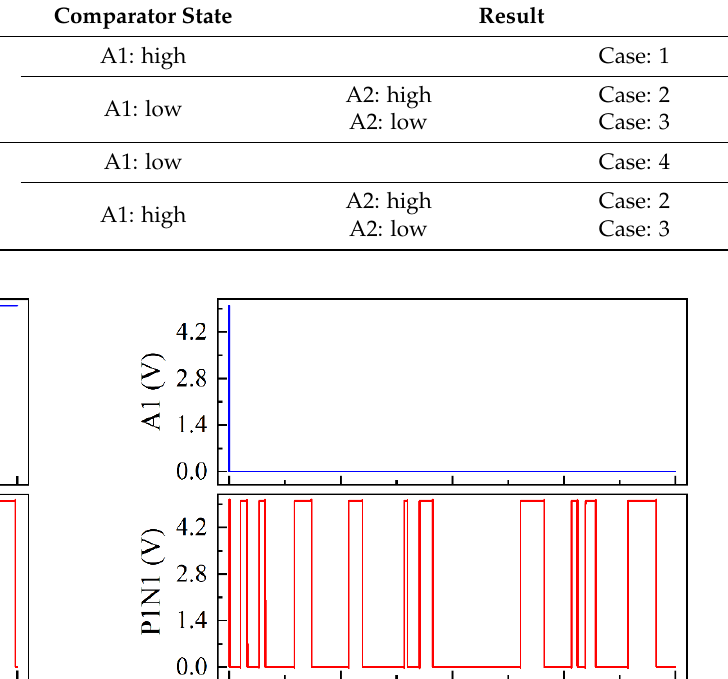
Figure 11. The logic results of control loop: ( a ) A1 output is high; ( b ) A1 output is low.